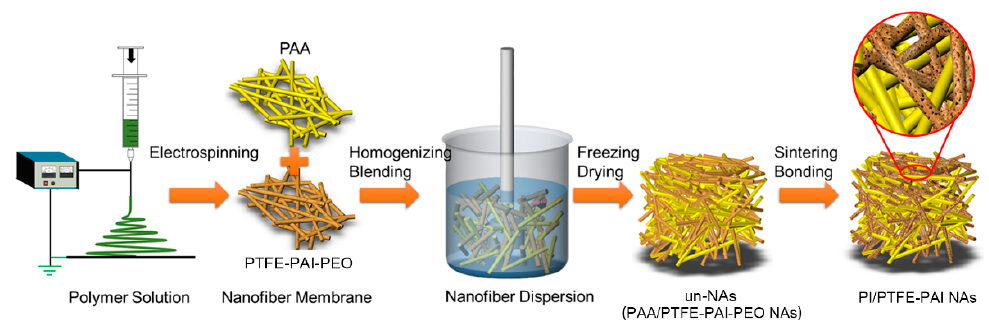
Figure 1. Schematic of preparation of PI / PTFE–PAI NAs via reconstruction strategy. PI, polyimide; PTFE, polytetrafluoroethylene; PAI, polyamideimide.